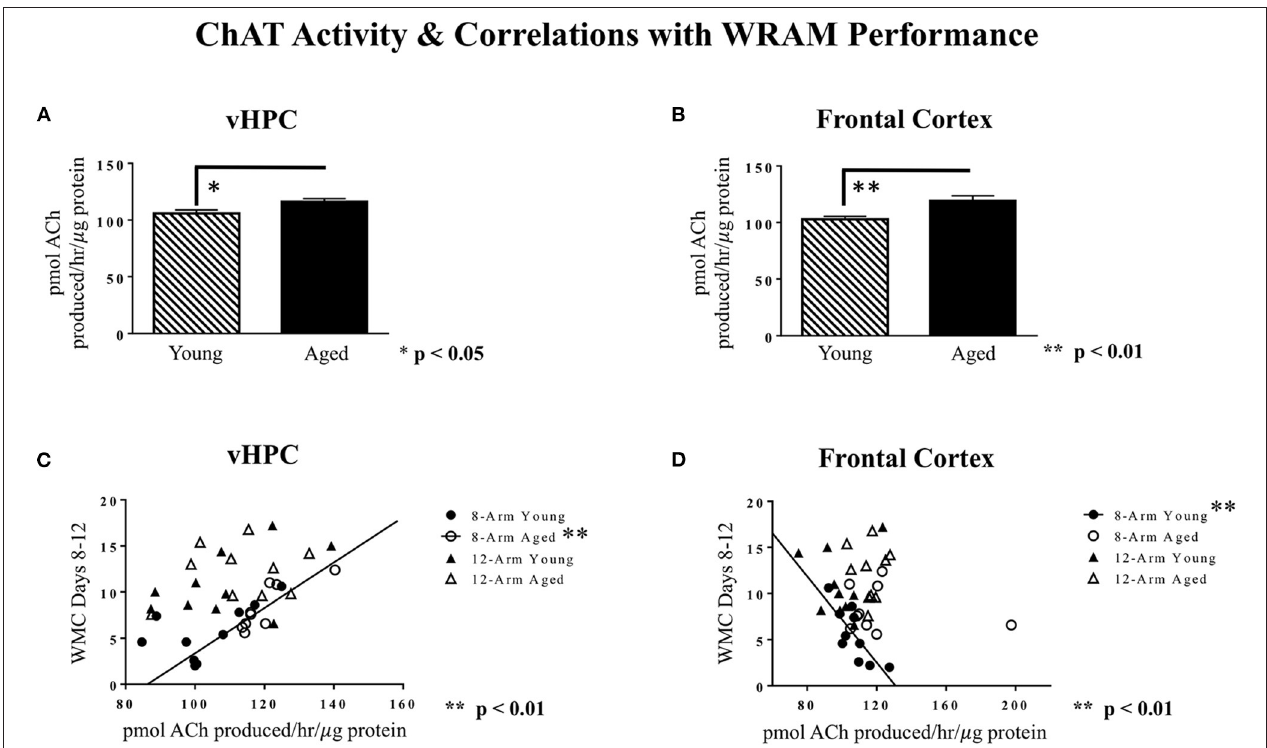
FIGURE 8 | ChAT activity in various brain regions, and correlations with WRAM performance. (A) Average ChAT activity levels in the ventral hippocampus, where aged rats had greater ChAT activity. (B) Average ChAT activity levels in the frontal cortex, where aged rats had greater ChAT activity. (C) A significant positive correlation was found between ChAT activity in the ventral hippocampus and WMC errors made during the Asymptotic Phase for aged rats performing on the 8-Arm WRAM specifically [ R 2 = 0.70, r (7) = 0.84, ** p < 0.01). (D) A significant negative correlation was found between ChAT activity in the frontal cortex and WMC errors made during the Asymptotic Phase for young rats tested on the 8-Arm WRAM [ R 2 = 0.61, r (8) = − 0.78, ** p <